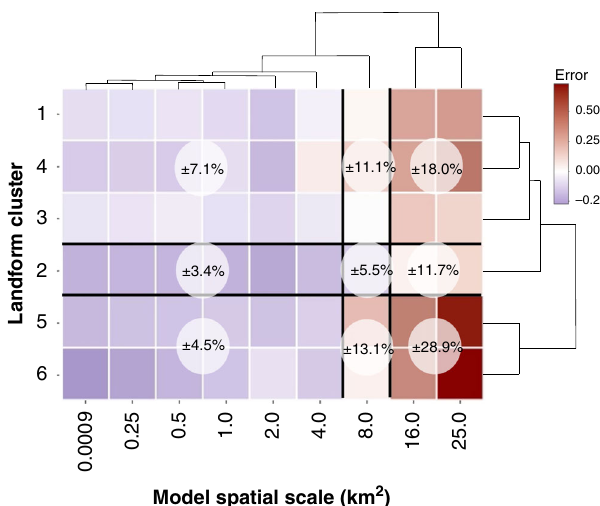
Fig. 8 Heat-map of random error for all tundra heterogeneity and model spatial scales. Warm to cool colors represent high to low random error (transformed to improve visualization). Hierarchical clustering grouped random error for all landform clusters (i.e., landforms and groups to represent the heterogeneity on the Barrow Peninsula) using a ~50% similarity cut-off for group membership. Mean random errors (transparent white circles) are presented for each landform cluster and model spatial